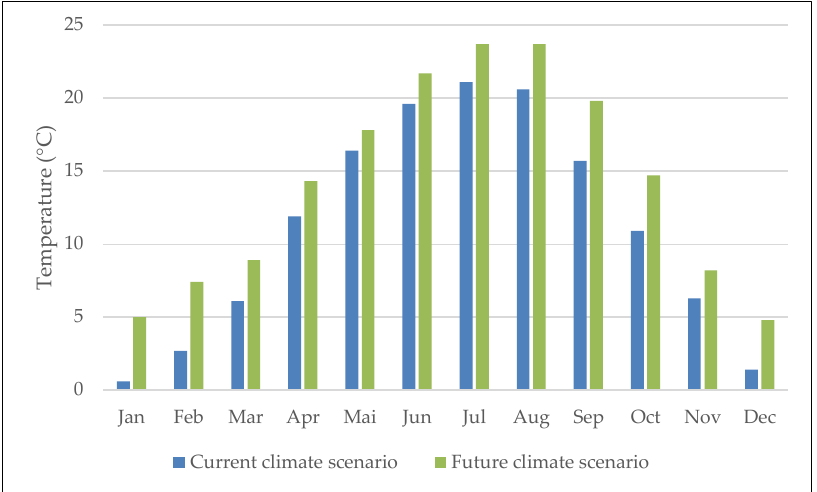
Figure 2. Monthly mean temperature based on long-term measurements (1991 – 2010) for the location Wien Hohe Warte [30].